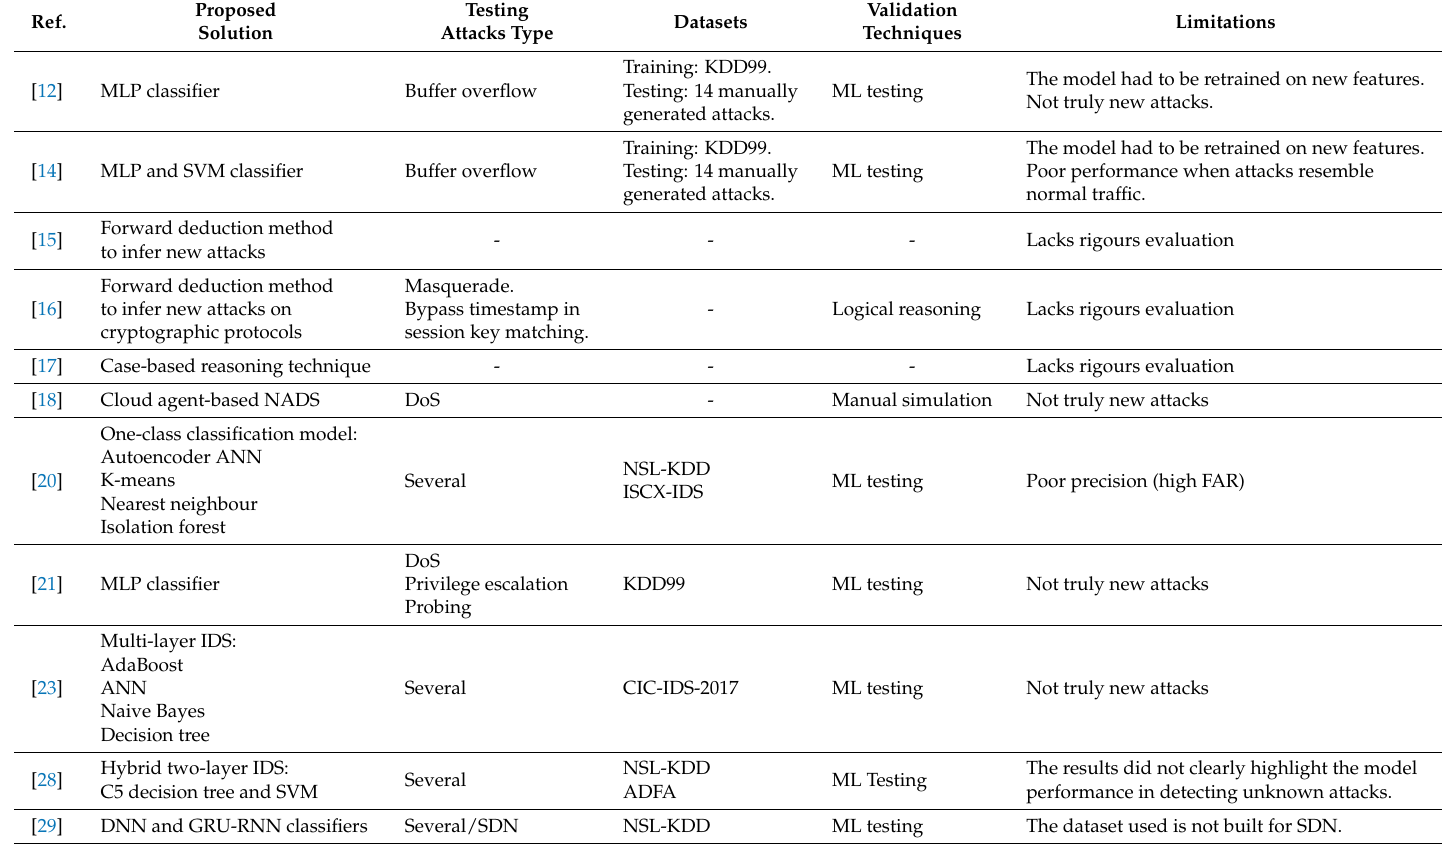
Table 1. Summary of the related